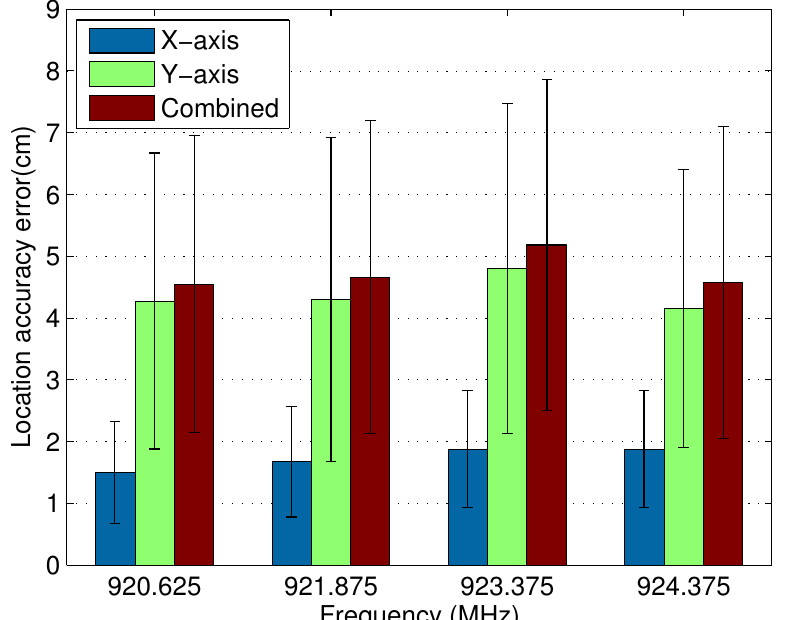
Figure 9. Localization accuracy error comparison with regard to the frequency. The bars represent the average localization accuracy errors in x-axis, y-axis and combined dimension,